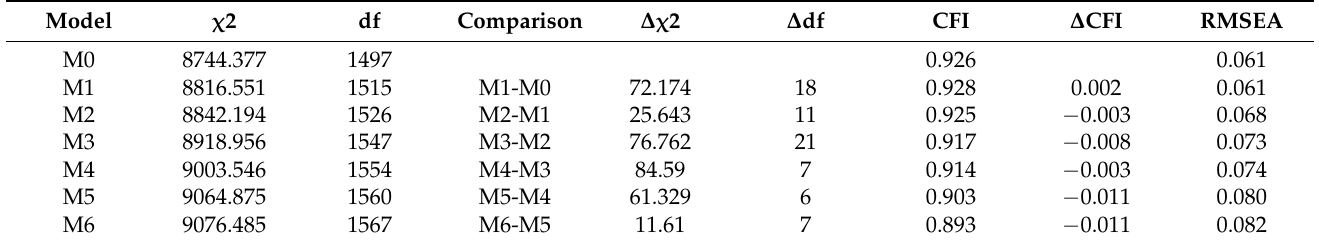
Table 4. Testing for Factorial Invariance of a Second-Order Factor Model across